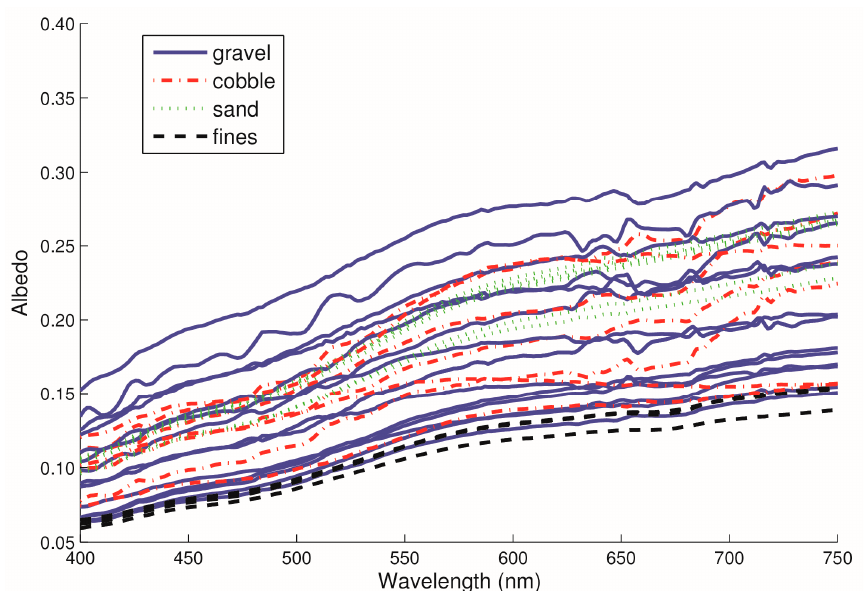
Figure 10. Albedo measured for different bottom types of the Wabash River and the Tippecanoe River.